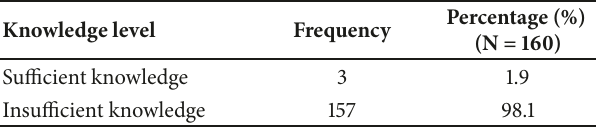
Table 2: Knowledge levels of midwives on neonatal resuscitation.